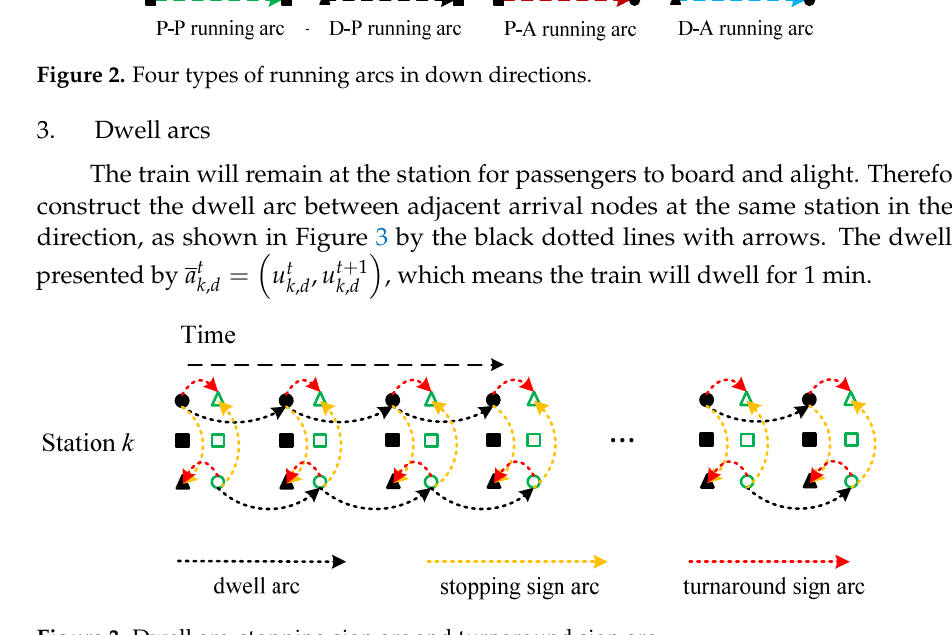
Figure 2. Four types of running arcs in down directions.